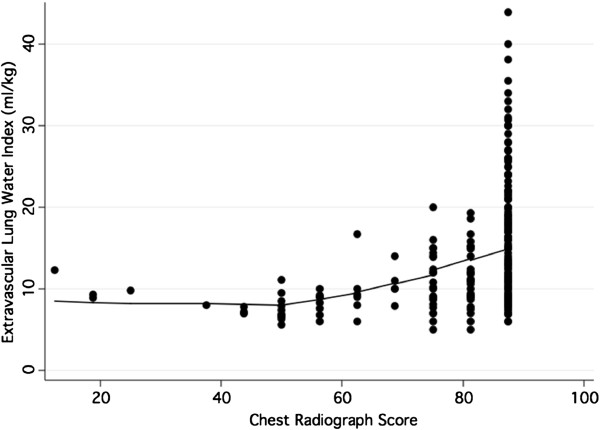
Scatter plot of extravascular lung water index (EVLWI) versus chest radiograph score with a Lowess smoothing line. EVLWI measurements and chest radiograph scores are from all days for which data are available (n = 476).